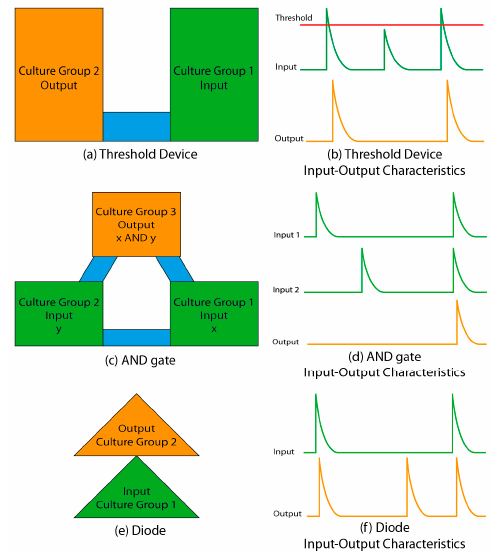
Figure 4. Neuronal implementation of functional logic gates. Adapted by permission from Macmillan Publishers Ltd.: [63] Left: Green color indicates input regions, blue shows bridges that contain axonal paths, and orange indicates an output region. Right: Green lines show conceptual input and orange lines show conceptual output (corresponding to fluorescence changes induced by changes in [Ca 2+ ] during population bursts). The vertical axis corresponds to burst strength, while the horizontal axis represents time. ( a ) Threshold Device Geometry and its ( b ) Input-Output Characteristics; ( c ) AND gate, and its ( d ) Input-Output Characteristics; ( e ) Diode and its ( f ) Input-Output